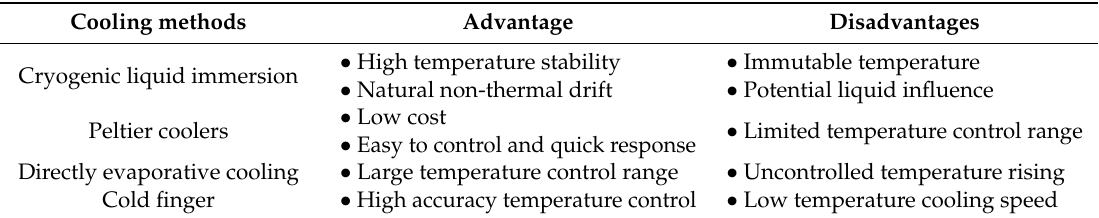
Table 2. Advantages and disadvantages of existing cooling methods.